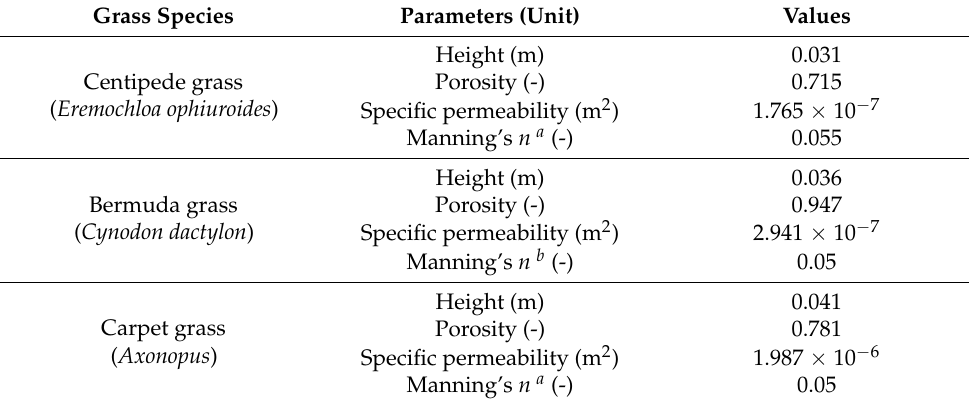
Table 1. Selected parameters of the grass layer. Grass Species Parameters (Unit) Values Height Centipede grass ( Eremochloa ophiuroides )